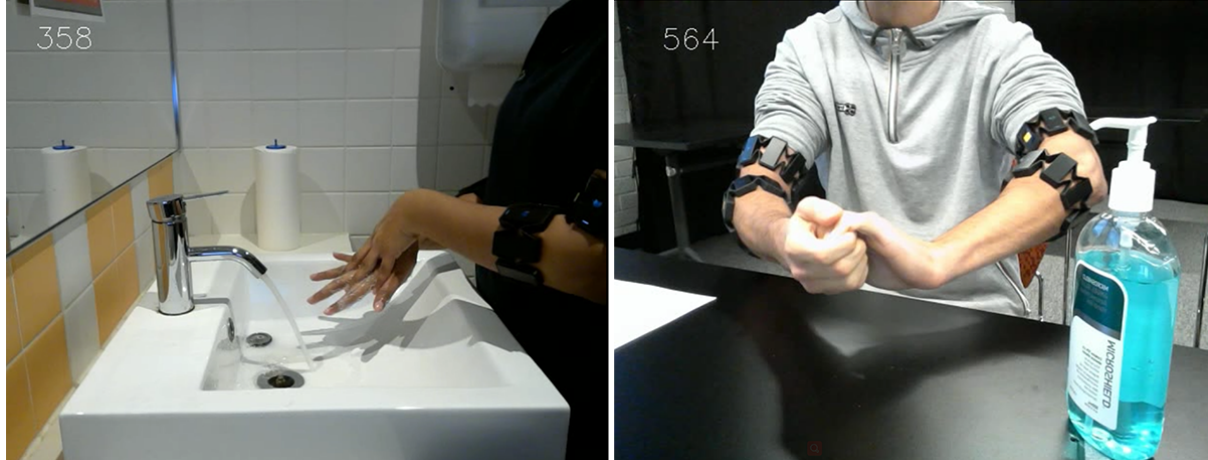
Figure 3. Screenshots of the video records of handwash with soap and water (left) and alcohol-based handrub (right). The frame number (top left) is used to synchronize video data to the armband